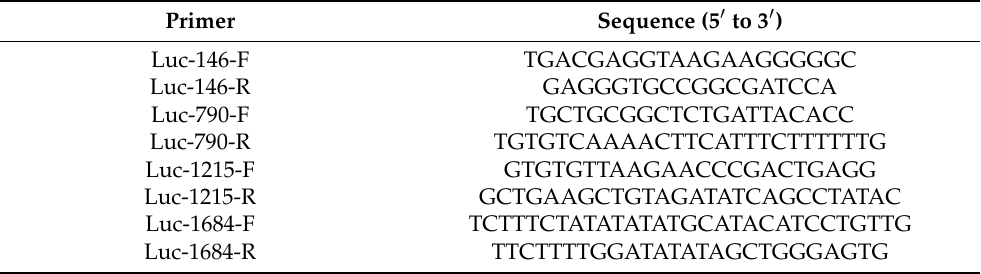
Table 2. PCR primers for the ChIP assay.